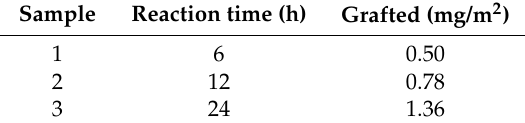
Table 2. Characterization of GAEMA grafted silica particles with reaction times from 6 to 24